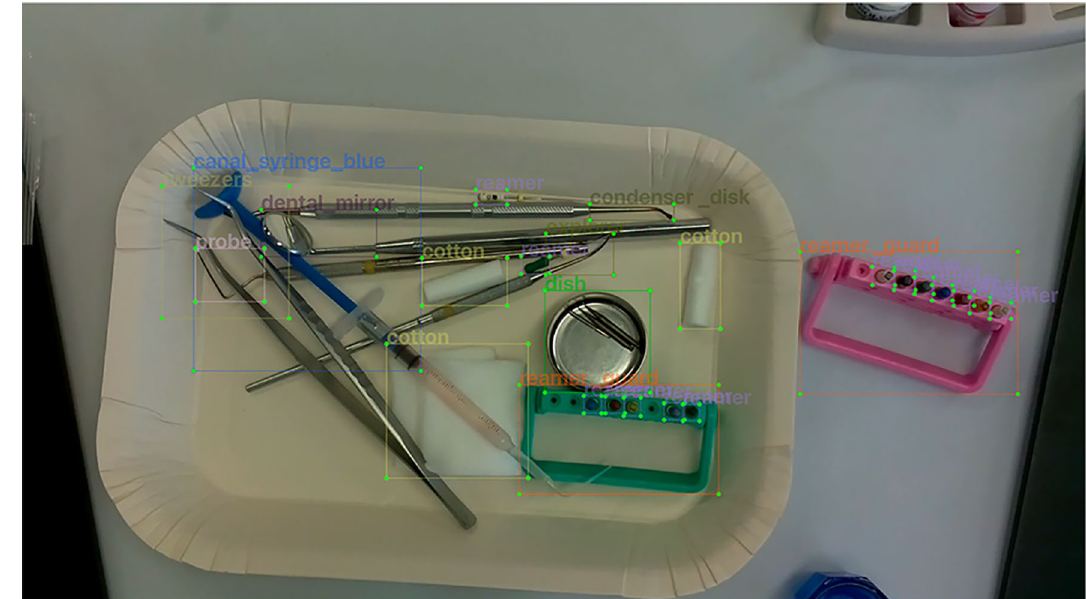
Figure 2. Example of labeling of instrument-specific part (AA). Only the characteristic parts of the instrument to be detected were surrounded by BBs and labeled to record the type of instrument.